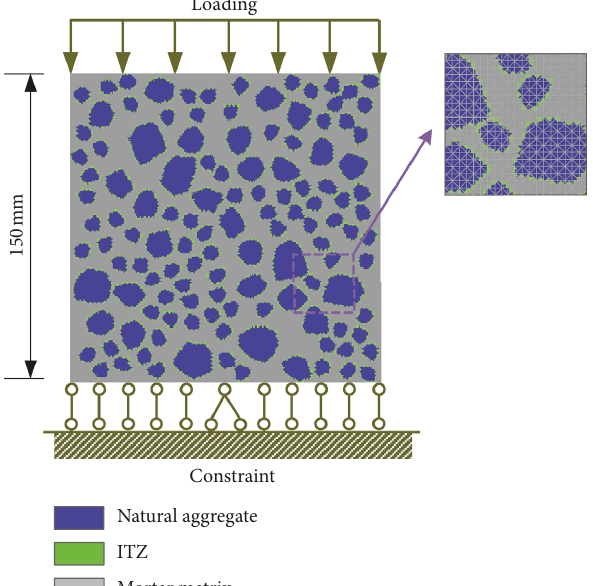
Figure 9: Simplified random aggregate loading model.